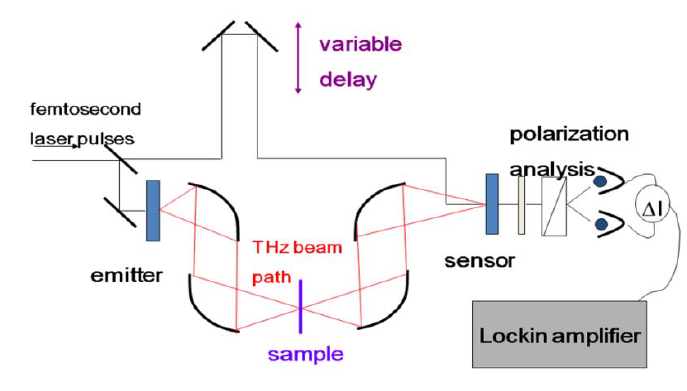
Figure 14. Sample THz time-domain spectroscopy experimental